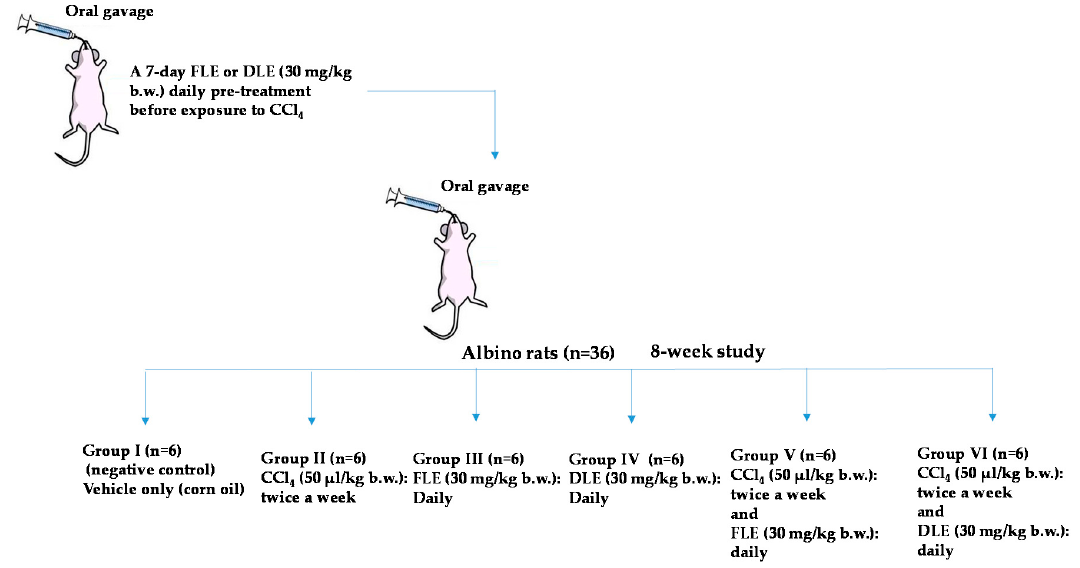
Scheme 1. Graphical scheme summarizing the experimental design, n : number of